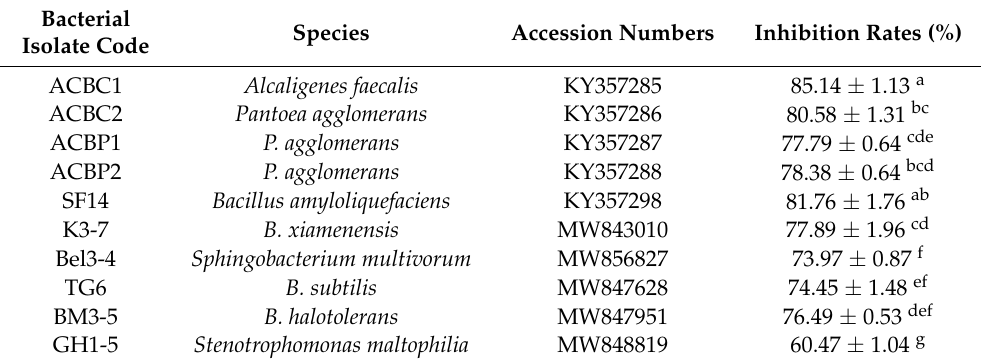
Table 2. The in vitro inhibition rates (%) of the P. schmitthenneri mycelial growth after 6 days of incubation at 25 ◦ C in darkness.